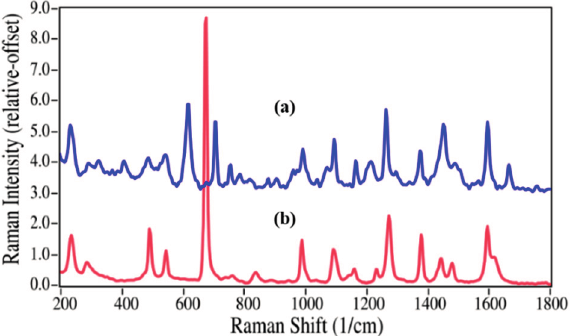
Figure 3. ( a ) Raman spectra of ( a ) Lidocaine (intensity × 5); and ( b ) 2,6-dimethylaniline. Spectral conditions as in Figure 2.